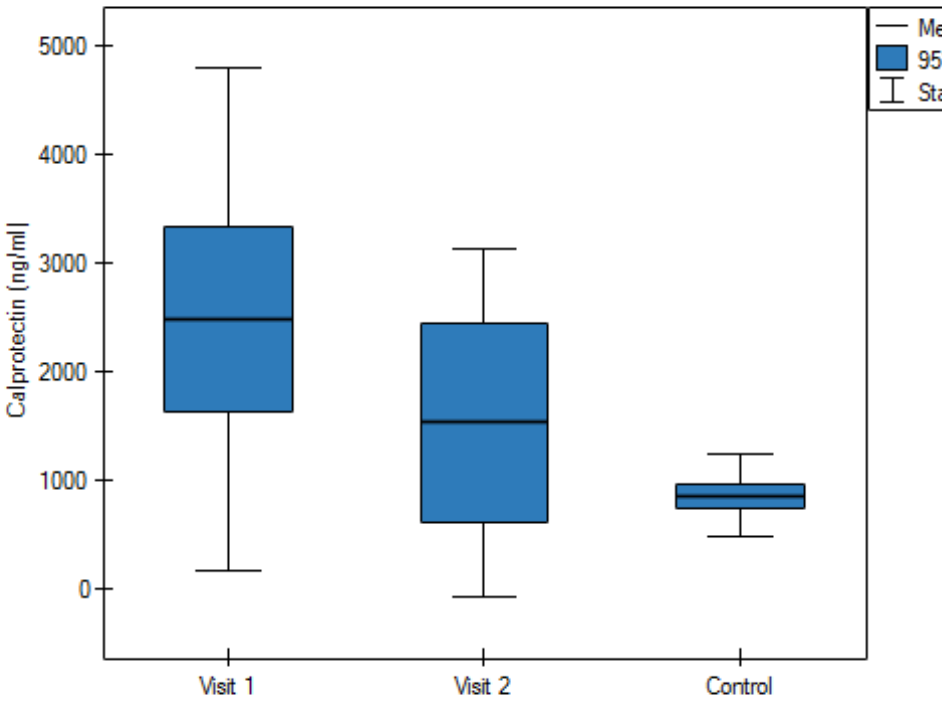
Figure 1. Average value of plasma concentration of calprotectin in the control group and study group during the first and second visit.